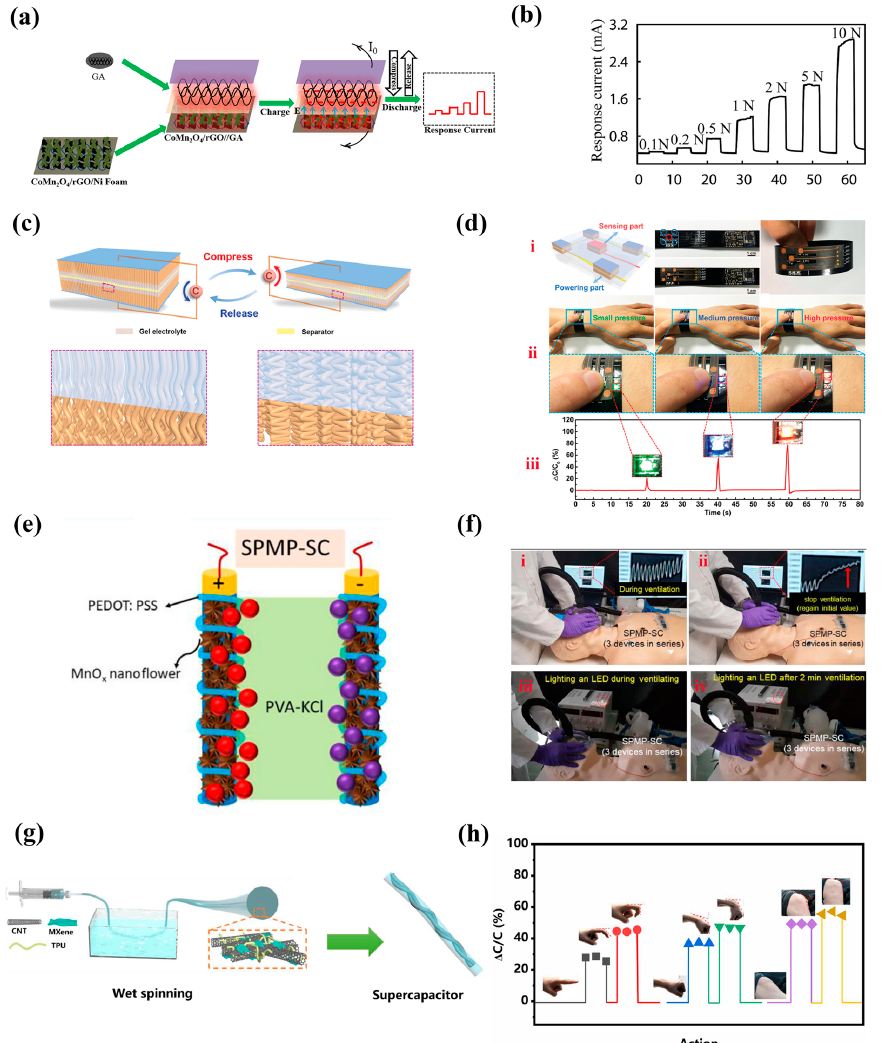
Figure 3. ( a ) Schematic illustration and application of GA-based supercapacitors and ( b ) its I–t curves at different pressures ranging from 0.1 to 10 N. Reprinted with permission from Ref. [70]. Copyright 2018, Journal of Power Sources. ( c ) CCNAs-based supercapacitors function as a strain sensor before and after compressing. ( d ) i. Schematic diagram and photographs of the integration of CCNAs-based supercapacitors. ii. Different degrees of pressure being applied on the integrated system to light up LED. iii. Relative capacitance responses obtained from the CCNAs-based supercapacitors during Materials. ( e ) Schematic illustration of SPMP-SCs. ( f ) Dual function of the SPMP-SC (i, ii) as